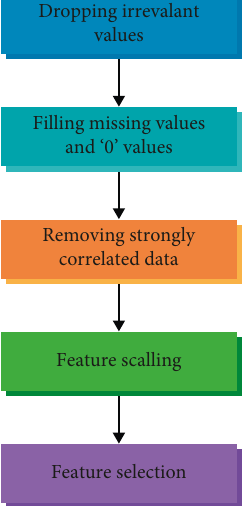
Figure 5: Data preprocessing